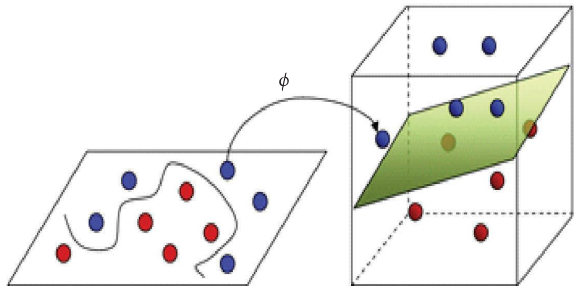
Figure 9: Schematic diagram of the SVM model.